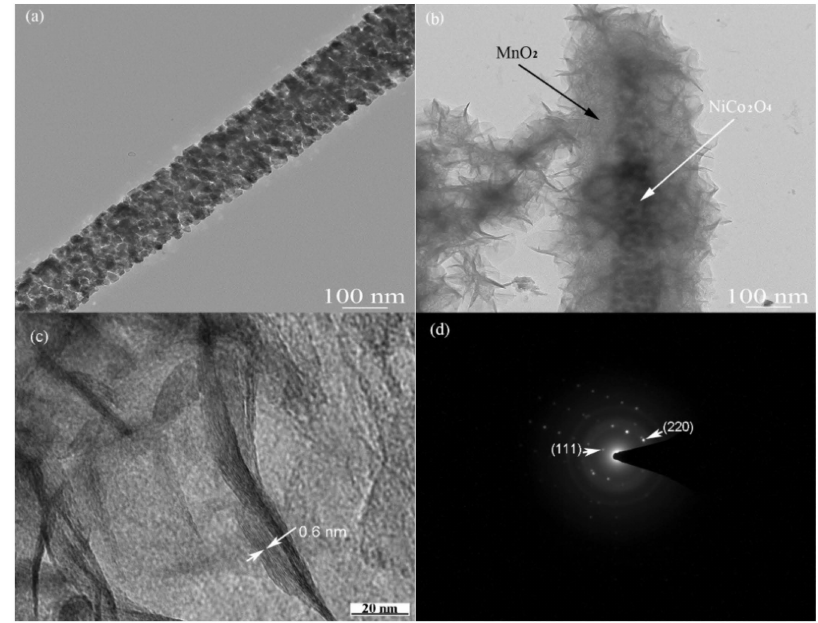
Figure 4. TEM images of ( a ) a NiCo 2 O 4 nanowire, ( b , c ) MnO 2 @NiCo 2 O 4 nanowires and ( d ) their electron di ff raction